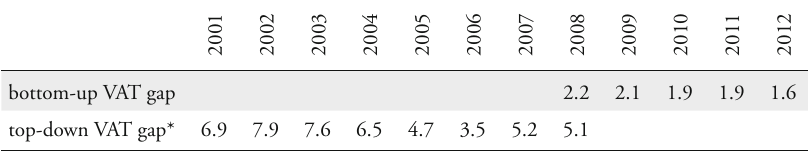
Table 8: VAT Gap Estimates 2001–2012 in Percent of the Actual VAT Revenue 200120022003200420052006200720082009201020112012 bottom-up VAT gap 2.2 2.1 top-down VAT gap*